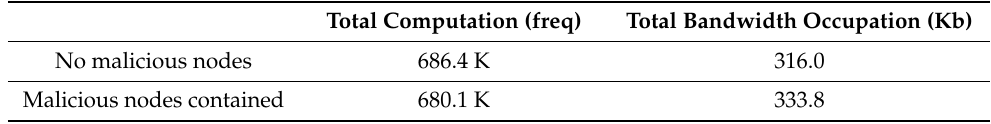
Figure 16. Resource occupation of the DDPOS algorithm with no malicious nodes.